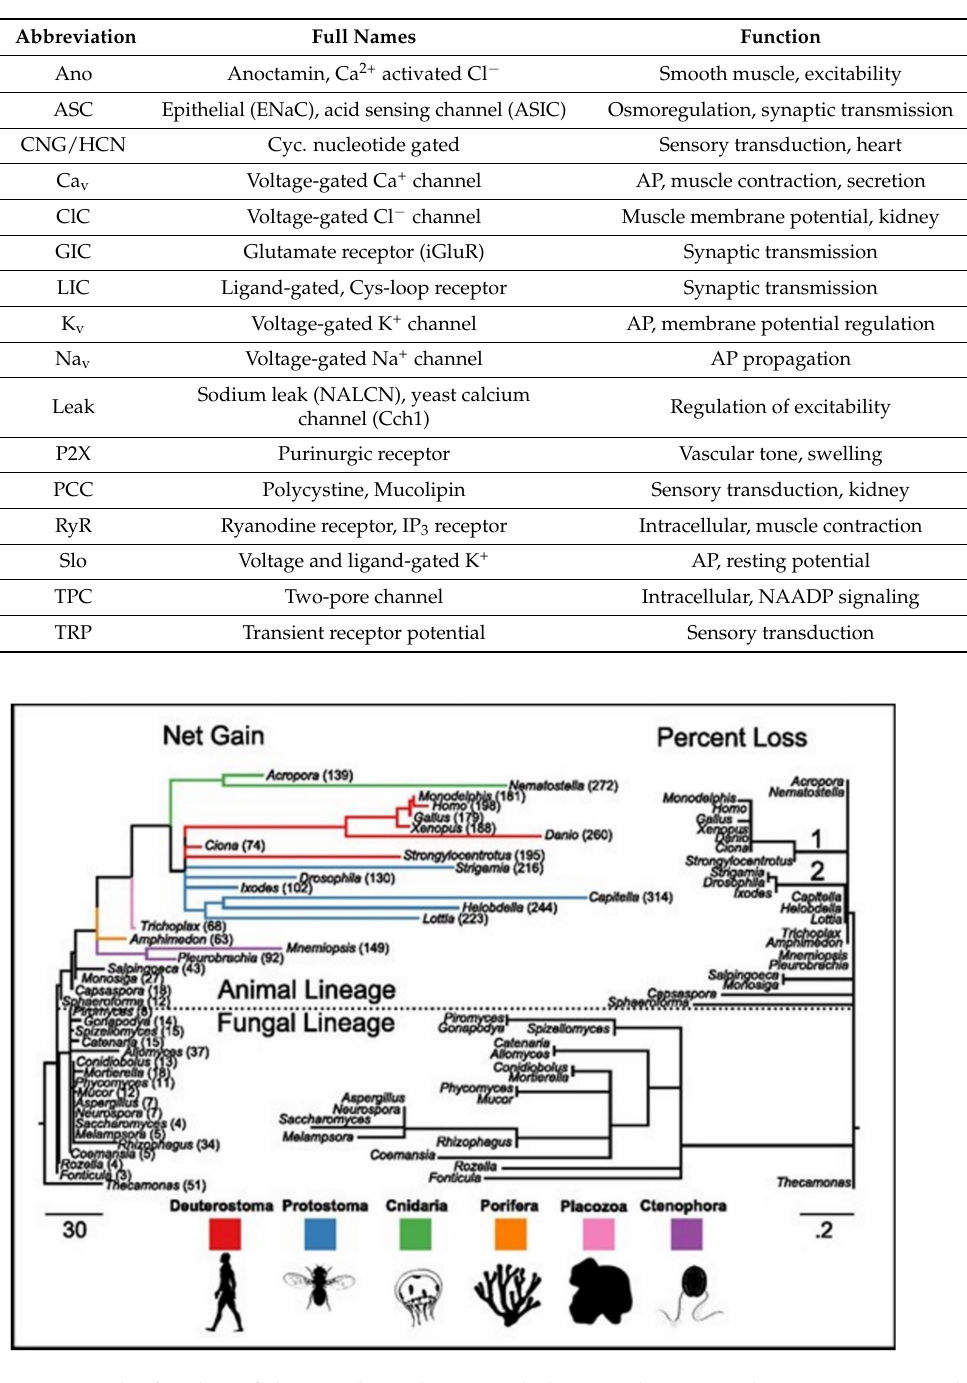
Table 2. Ion channel families [15].